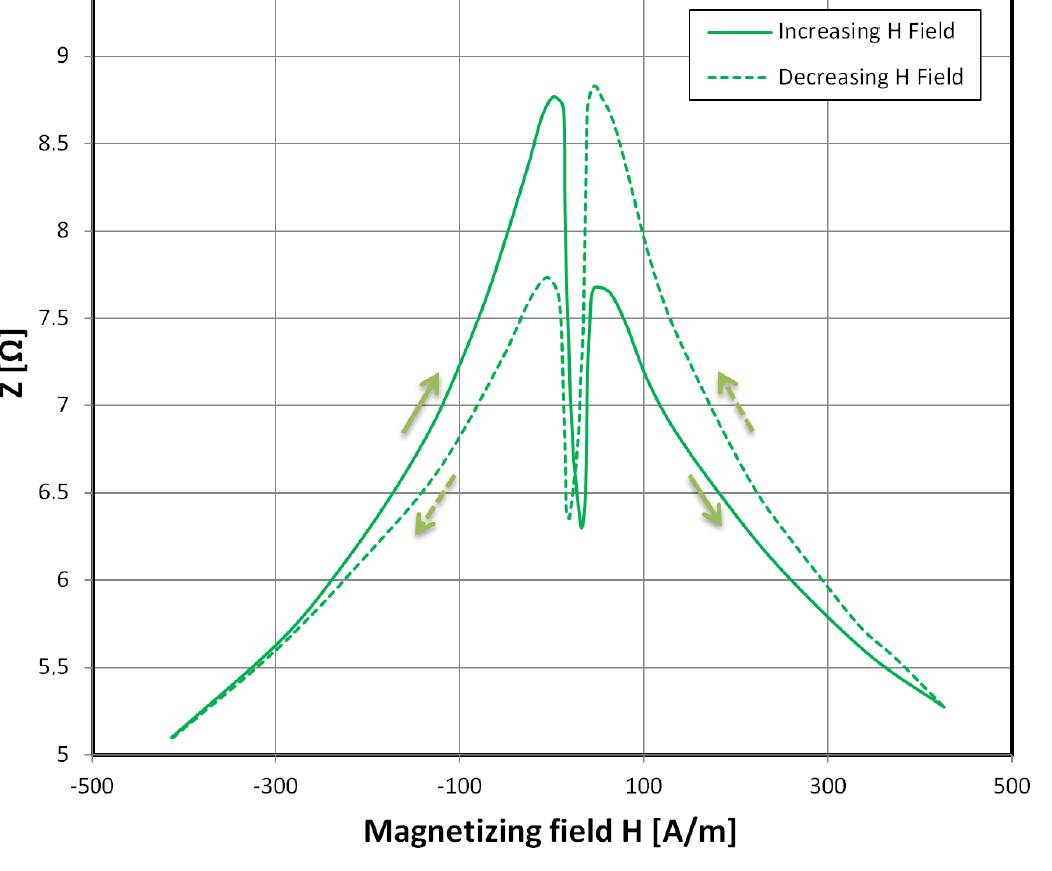
Figure 2. Hysteretic dependence of sample impedance (for a 1 MHz driving signal) on a changing magnetizing field H applied longitudinally. The green line indicates the characteristics for an increasing H field and the green dashed line indicates the characteristics for a decreasing H